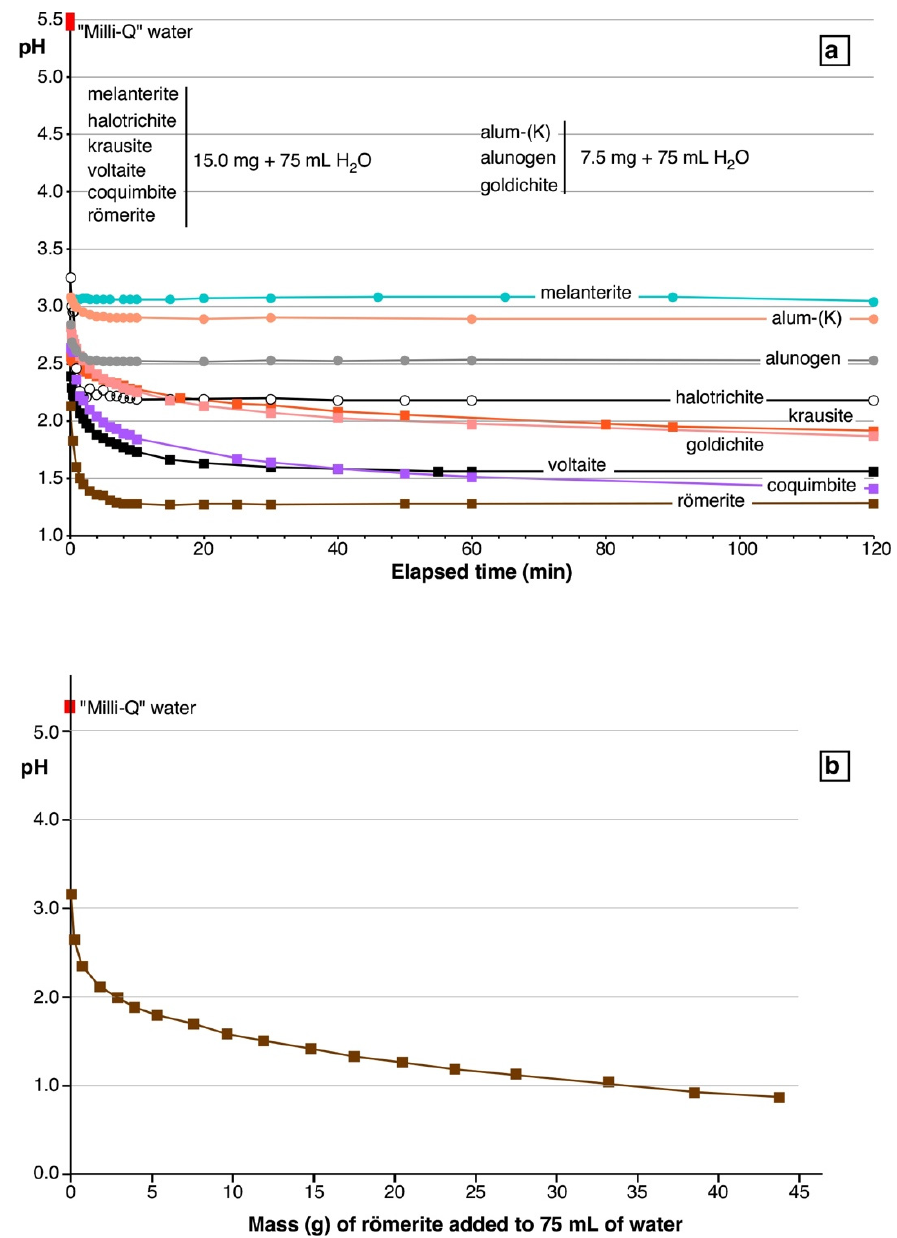
Figure 6. Relationships between measured pH and elapsed times in the dissolution experiments of the studied sulfates ( a ). In ( b ), the pH variation as a function of the dissolved mass of römerite is shown.